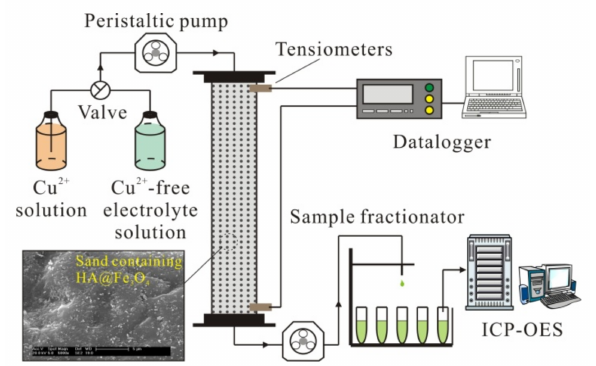
Figure 1. Schematic of the experimental